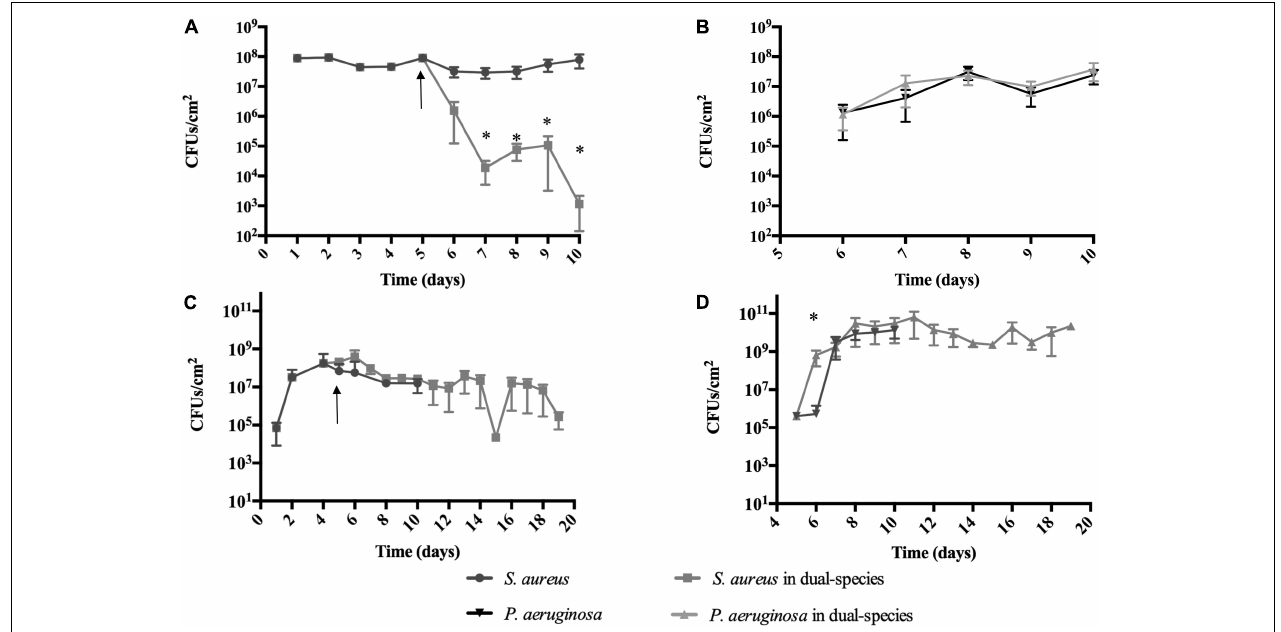
FIGURE 2 | Staphylococcus aureus persists in co-culture with P. aeruginosa on abiotic surfaces. S. aureus was allowed to establish a biofilm for 5 days prior to the introduction of P. aeruginosa. P. aeruginosa was introduced at a concentration of 1 P. aeruginosa to 250 S. aureus . Dual-species growth and bacterial maintenance was determined in various growth conditions: (A,B) 20% BHI at 37 ◦ C under agitation at 220 rpm, (C,D) 10% BHI at 22 ◦ C under continuous flow conditions. Controls consisted of biofilms of axenic cultures. Bacterial viability and strain ratios were evaluated daily. (A) S. aureus viable counts, (B) P. aeruginosa viable counts, (C) S. aureus viable counts, (D) P. aeruginosa viable counts. ∗ p < 0.01 comparing to the axenic cultures. Arrow indicates introduction of P. aeruginosa